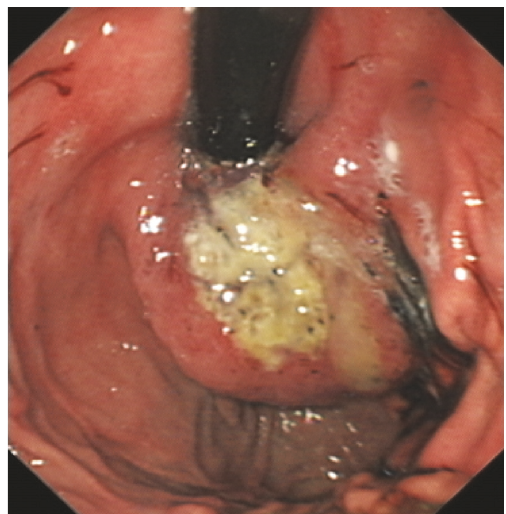
Figure 6: Lower oesophageal mass prior to stenting.